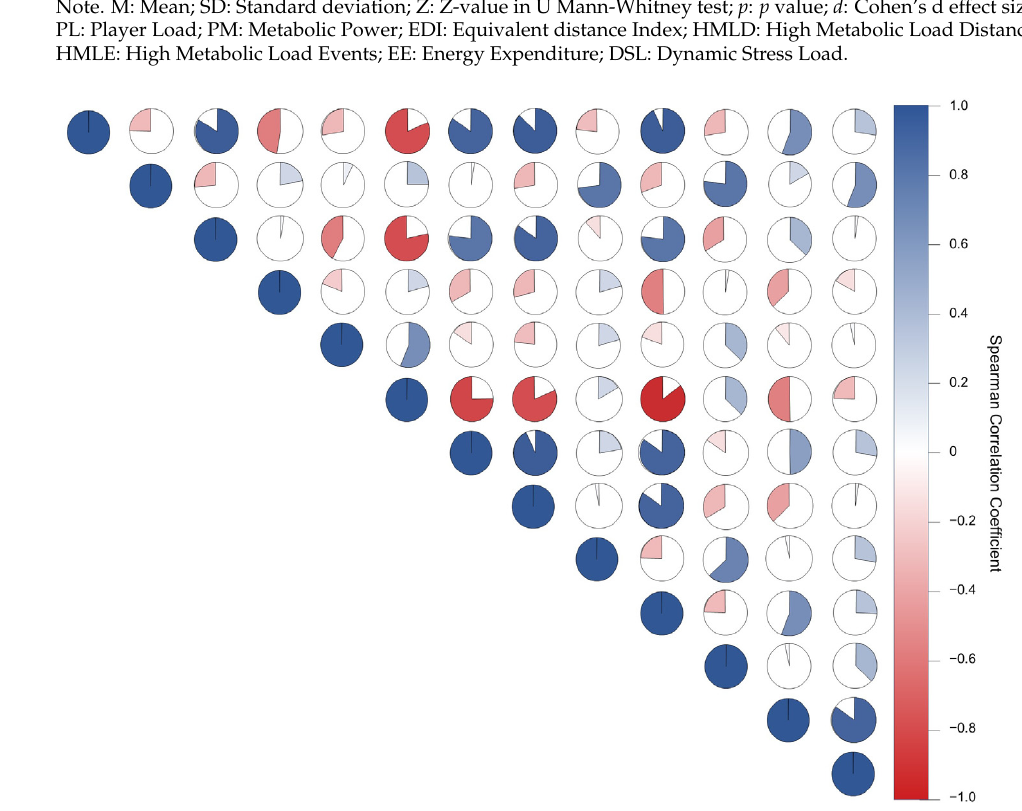
Figure 1. Pairwise Spearman correlation of the external load variables from official matches data in starting-up players.